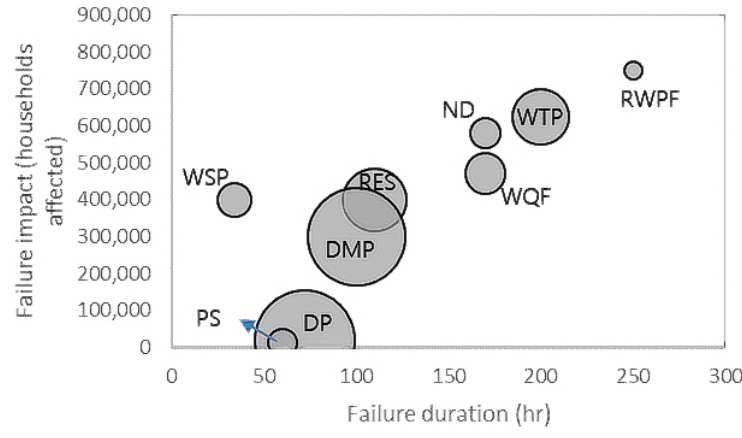
Figure 2. Example of the CID bubble plot.